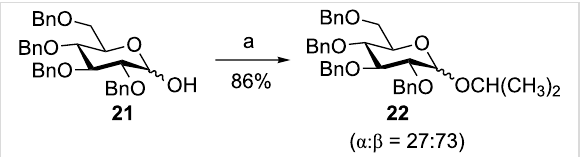
Scheme 6: Chemoselective dehydrative glycosylation. Reagents and conditions: (a) Ph 2 SO, Tf 2 O, 2-chloropyridine, then (CH 3 ) 2 CHOH, − 40